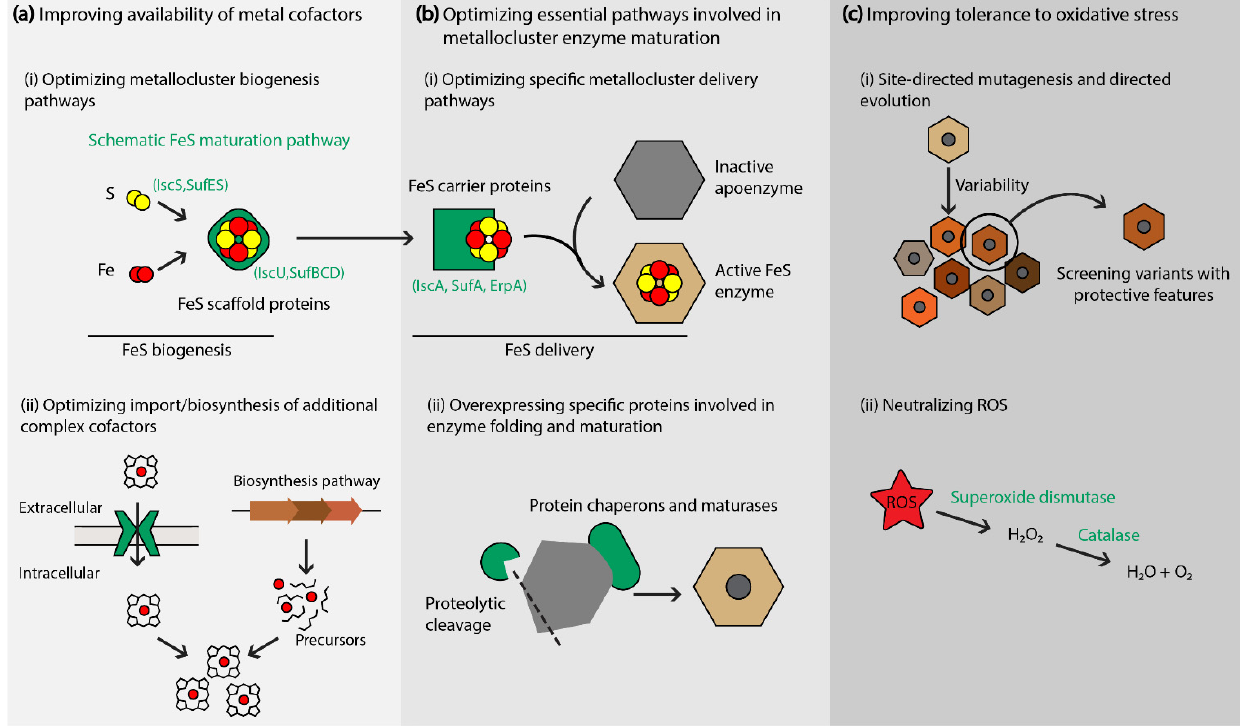
Figure 2. Strategies to enhance metallocluster enzyme maturation and stability. ( a , b ) A schematic representation of prokaryotic FeS maturation is presented as an example of the different steps and specific proteins involved in metallocluster enzyme maturation. The availability of metal cofactors can be improved by optimizing their biosynthesis or cellular import ( a ), or by optimizing essential pathways involved in post-translational modifications and protein maturation ( b ). ( c ) Reducing effects of oxidative stress.